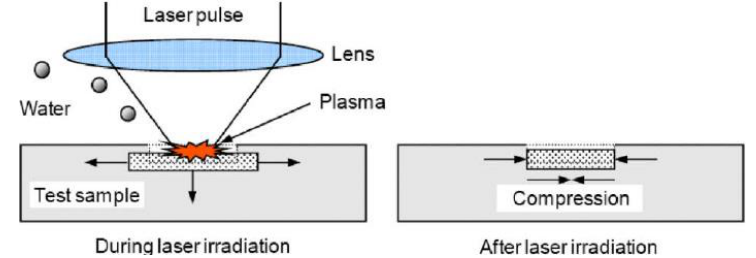
Figure 2. Fundamental mechanism of the LSP process.